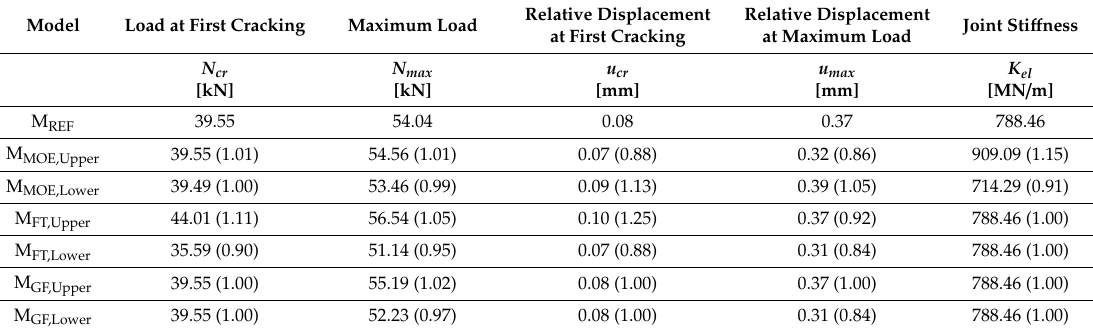
Table 6. Results of sensitivity studies.